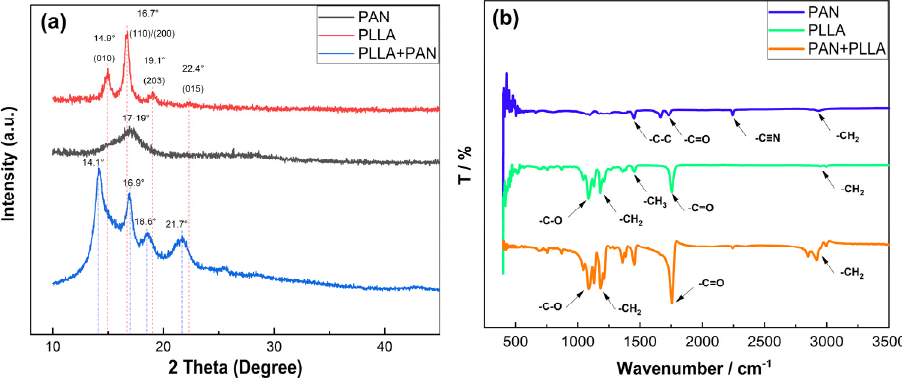
Figure 4. ( a ) XRD patterns of fibrous membranes, ( b ) FTIR patterns of fibrous